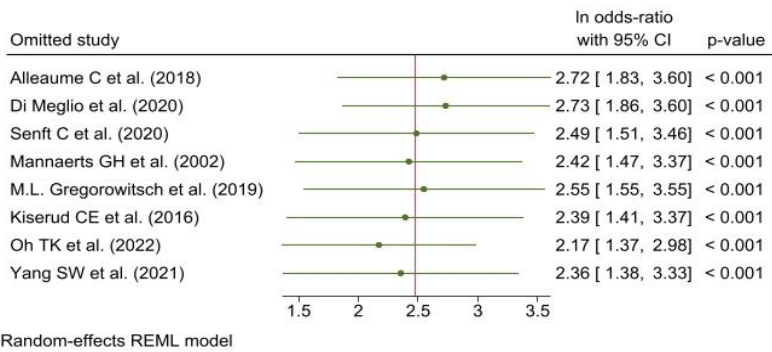
Figure 4. Leave-one-out analysis. [12,26 –